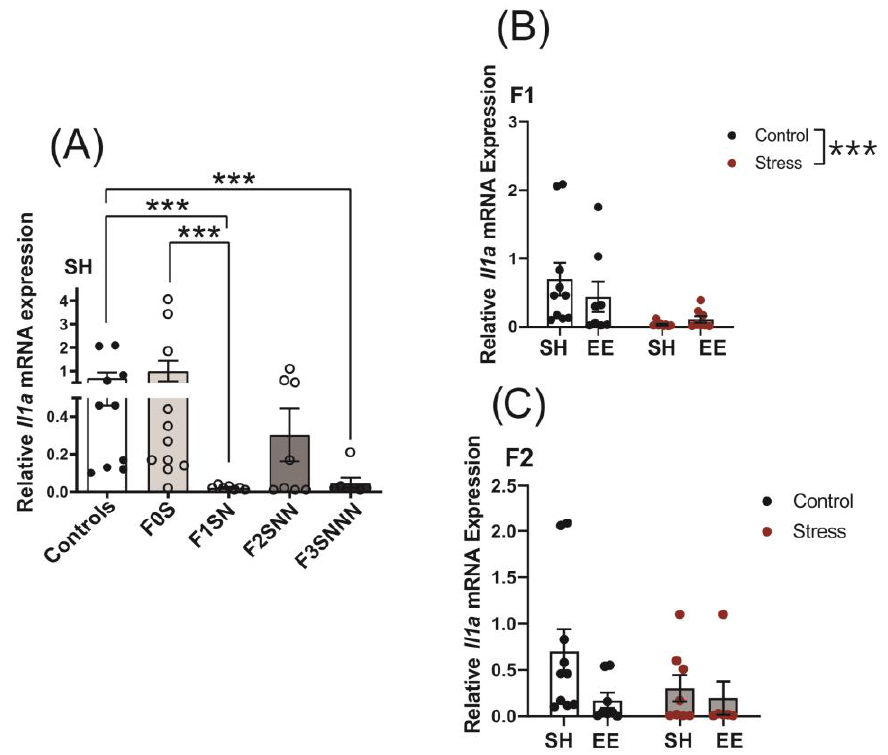
Figure 7. Uterine expression of Il1a was significantly downregulated in the F3 generation of stressed dams raised in SH and in F1 stressed animals exposed to both housing conditions. ( A ) Gene expression of Il1a in uteri of control and stressed dams across the F0–F3 generations. Uterine expression of Il1a in ( B ) F1 and ( C ) F2 animals exposed to different treatments and housing conditions. Asterisks indicate significance: <0.001 (***). Data are compared to F0N, mean ± SEM. Ordinary one-way ANOVA ( A ) and two-way ANOVA ( B , C ) analyses were used. N = 7–11 ( A ); 8–10 ( B ); or 6–10 ( C ). SH = standard housing; EE = enriched housing; F = filial generation; S = stressed; N = nonstressed. The expression of Il1b increased significantly in the F2 generation (F(4,42) = 5.491, p = 0.001; Figure 8A) compared to F0N and F0S ( p < 0.002 for both). A statistically significant interaction between treatment and housing (F(1,31) = 7.915, p = 0.008; Figure 8B) and a significant main effect of housing (F(1,31) = 4.239, p = 0.048) were revealed in the Il1b ex-